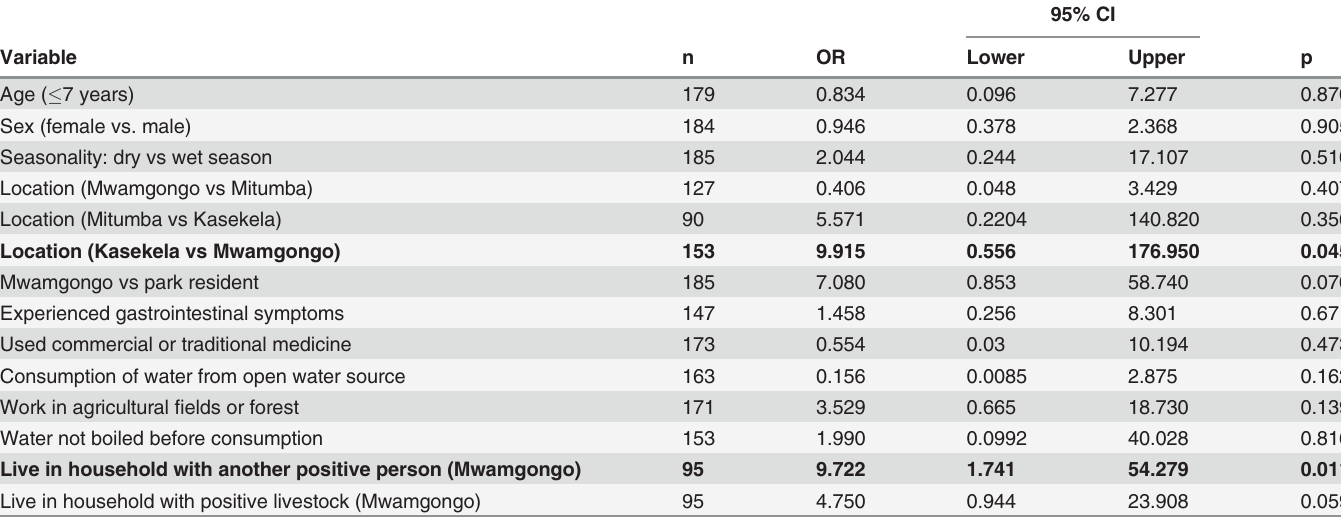
Table 2. Risk factors for Cryptosporidium infection in people living in or adjacent to Gombe National Park, Tanzania.